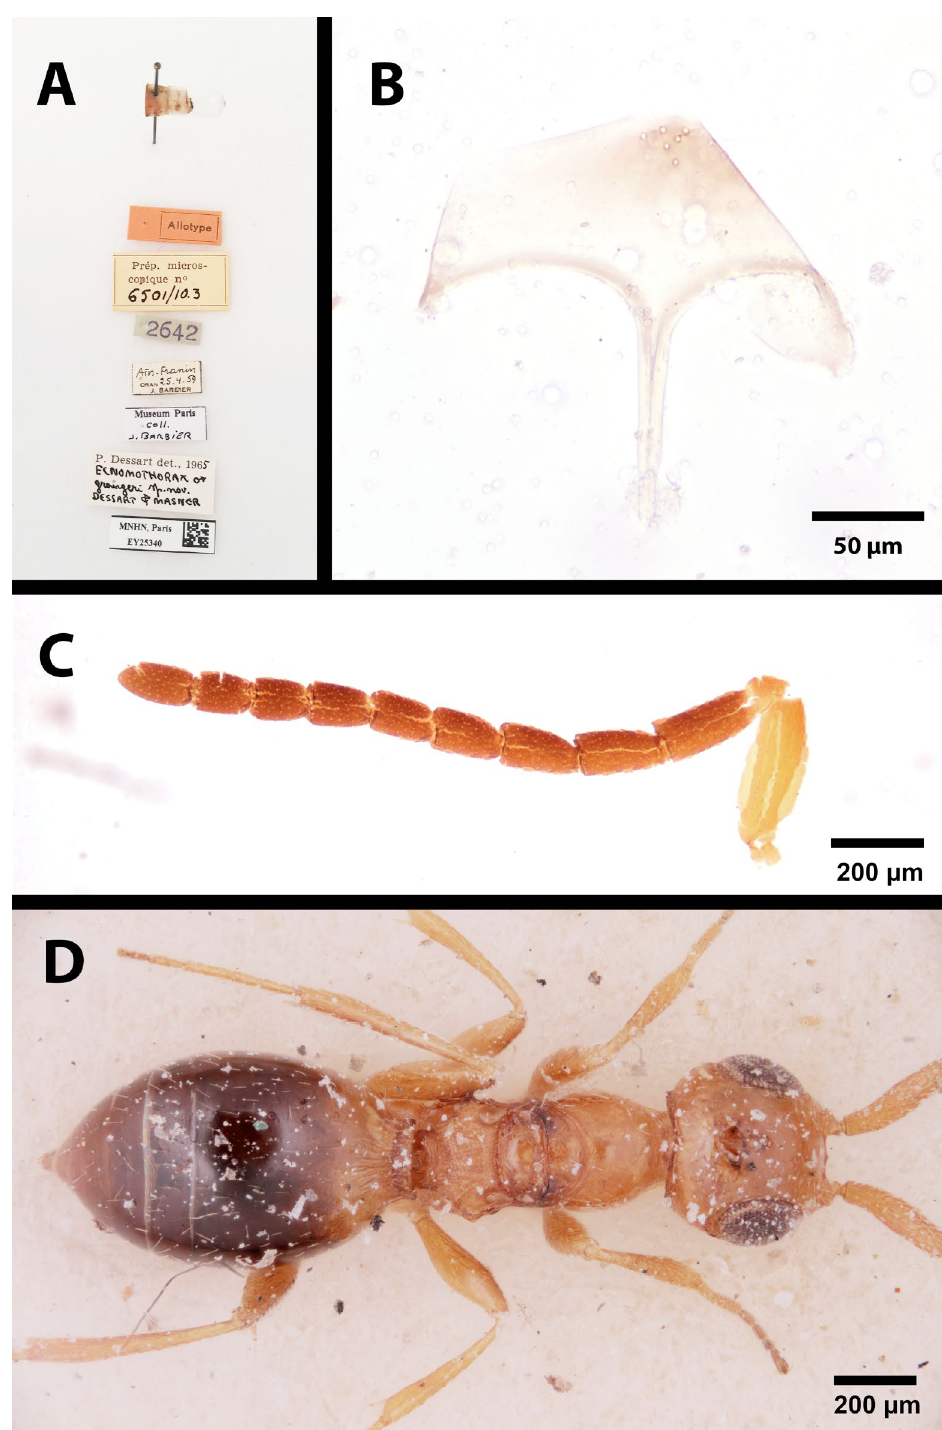
Fig. 19. Conostigmus grangeri (Dessart & Masner, 1965). A–C . Allotype, ♂. A . Labels and specimen (MNhN EY25340). B . S9, dorsal view (MNhN EY22444). C . Left antenna (MNhN EY22446). D . Paratype, ♂, dorsal habitus (MNHN